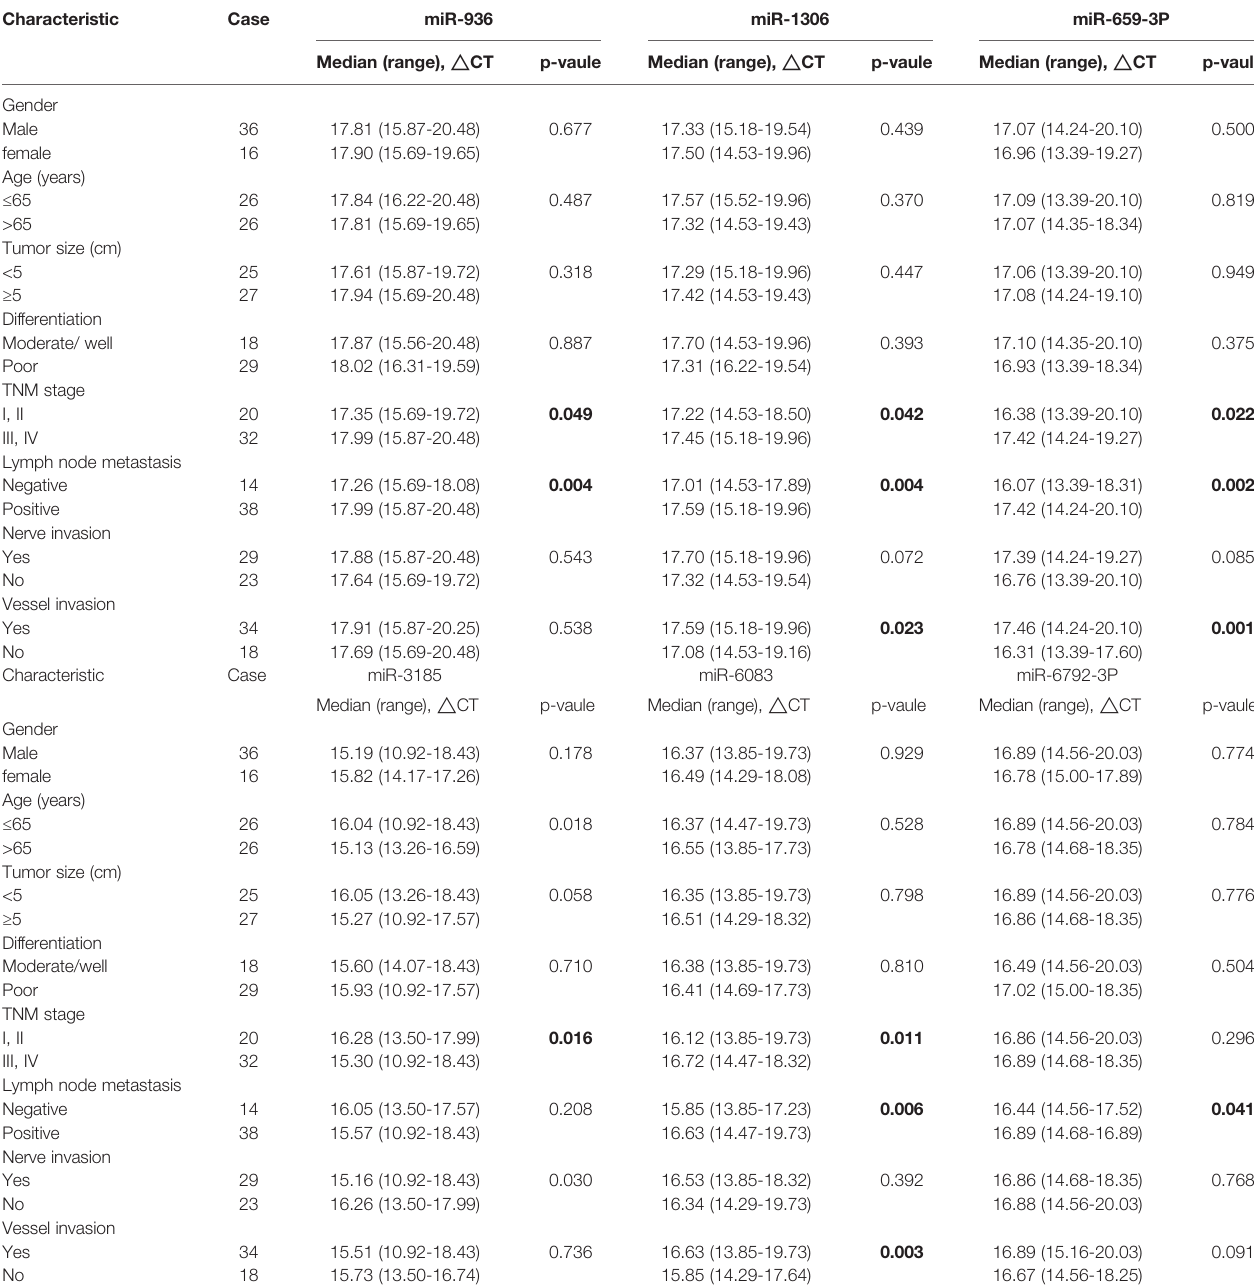
The bold values highlight statistical signi fi